Question: Generate an informative caption for the figure above.
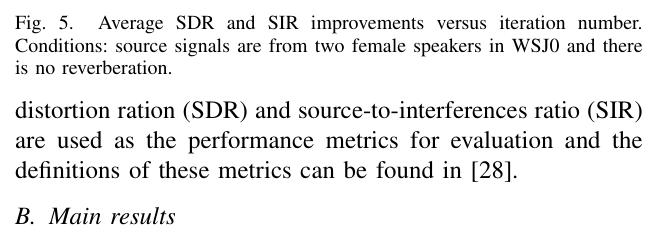
Answer: plots the averaged performance in different rever- berant environments. It is evident that the cILRMA method exhibits greater improvements in SDR and SIR compared to the other algorithms, although the discrepancy diminishes as the reverberation time increases. An essential parameter in the proposed source model is parameter O. To explore its impact on performance, a set of experiments were conducted. Figure 3 depicts the SDR and SIR improvements across various values of O, with the source signals originating from two female speakers. The results indicate that performance enhances with increasing values of O, suggesting that a higher O value leads to a more accurate source model.